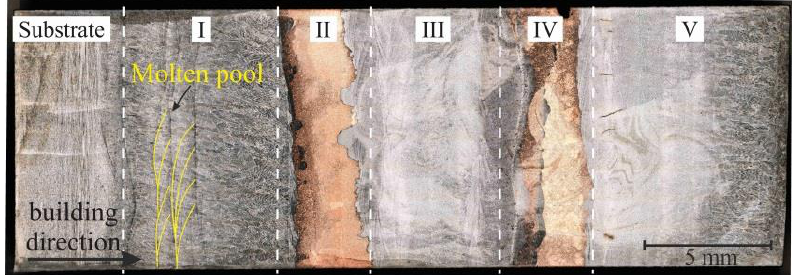
Figure 4. Optical microscopy of the longitudinal section of a sample of bimetal layered macrocomposite. The white dashed lines show the boundaries of the sample by zone. The boundaries of the melt pool are marked with yellow lines. The sample was divided into five areas: area I—the first 5 layers of stainless steel on the substrate; II and IV—5 layers of copper on the already deposited steel; III and V—stainless steel layers on the already deposited copper layers. Surface macrodefects formed during vertical wall growth do not affect the internal macrostructure of the sample, except for the disturbance of layer thicknesses. Due to the difference in melting temperature of the materials, a disturbance of the uniform thickness of the copper layer in the longitudinal section can be observed in Figure 4. The